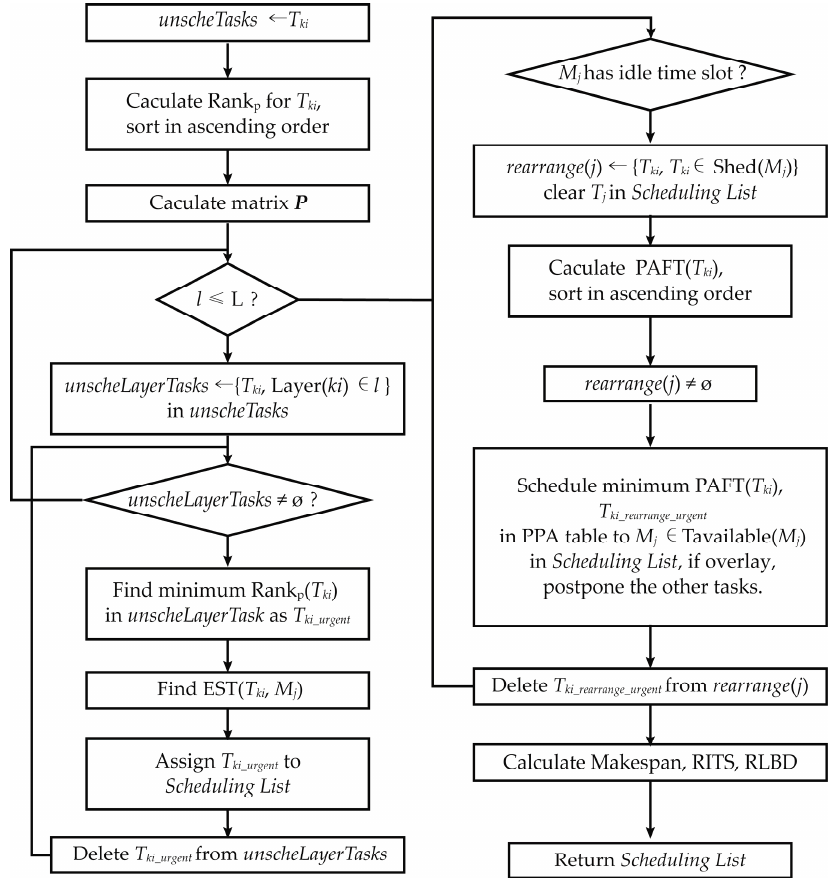
Figure 5. Flowchart of HPEFT.